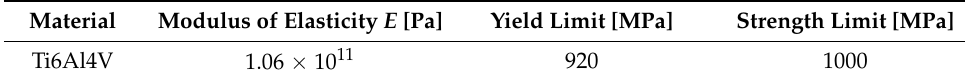
Table 3. Basic information on the material of the applied screws.